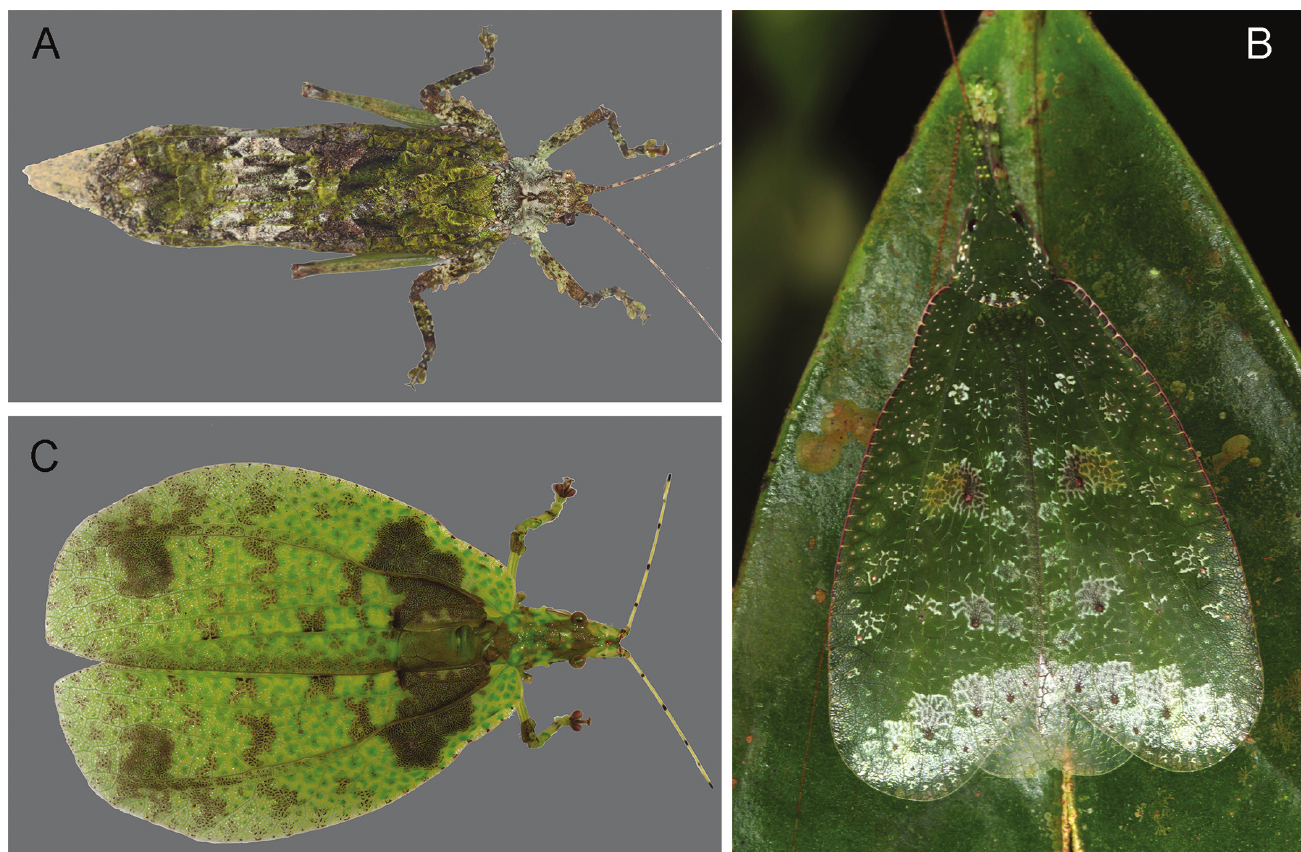
Fig. 17. Tettigoniidae: Pseudophyllinae: A. Olcinia dentata ; B. Phyllomimus sp.; C. Tympanophyllum